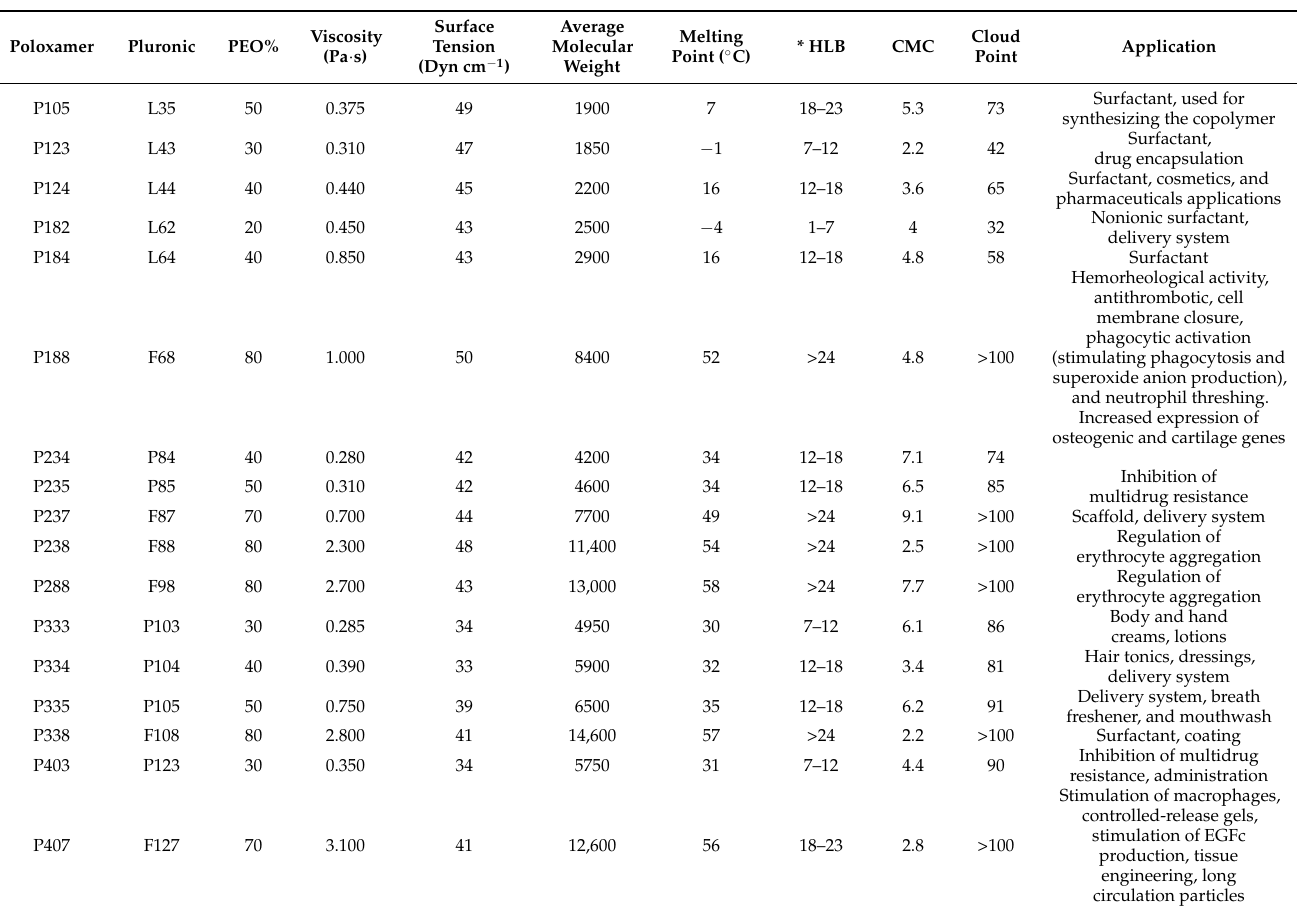
Table 1. The properties of the common [PEOx- PPOy- PEOx] copolymers. The table has been taken from the publication by Zarrintaj and Russo et al. [7,11] with